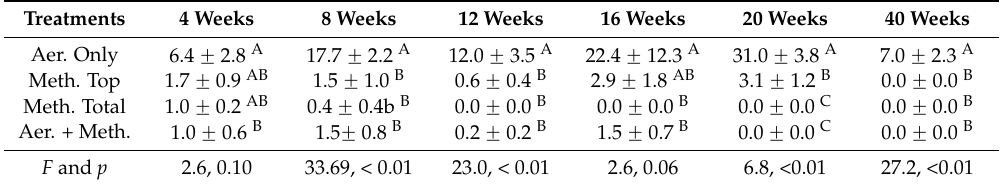
Meth. Top Meth. Total Aer. +